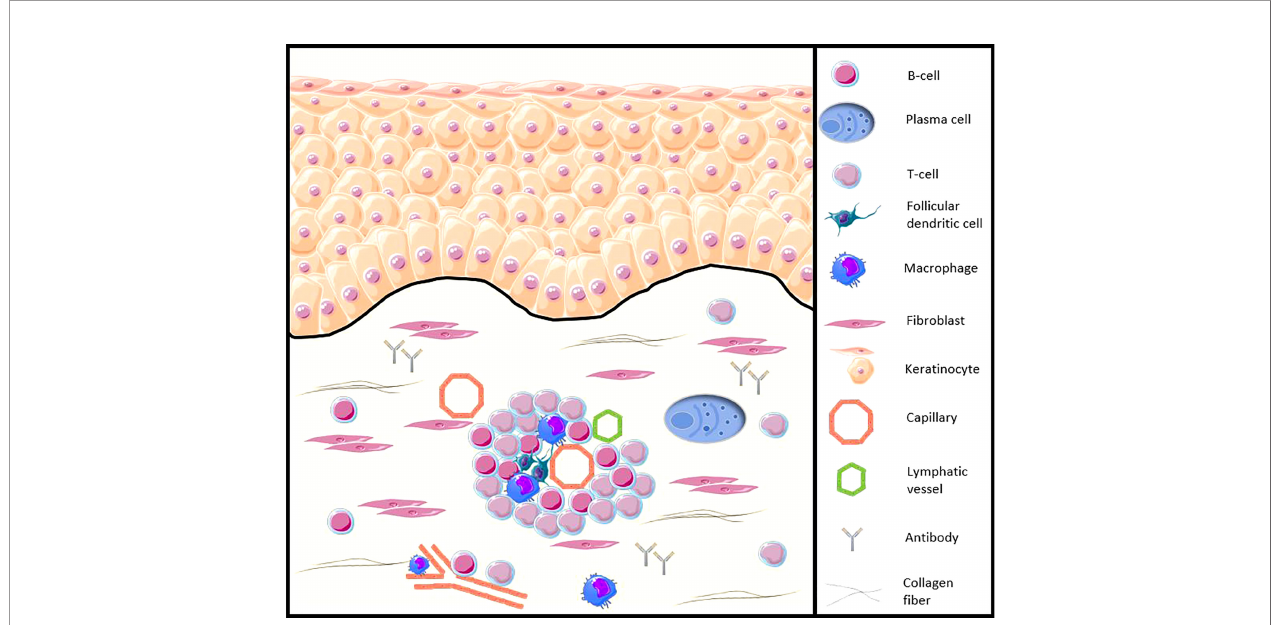
FIGURE 1 | Illustration of the B-cell presence in the SSc patients skin (adapted from Fetter et al. Cells, 2020 [13)]. CD20 + B-cells and plasma cells in fi ltrate the skin of SSc patients, from the early stages of the disease, especially around blood vessels, accompanied by other peripheral blood mononuclear cells, such as CD3 + T cells or follicular dendritic cells. B-cells participate in the functions of antigen-presenting cells, production of autoantibodies and proin fl ammatory and pro fi brotic cytokines, as well as direct contact with other cells such as the fi